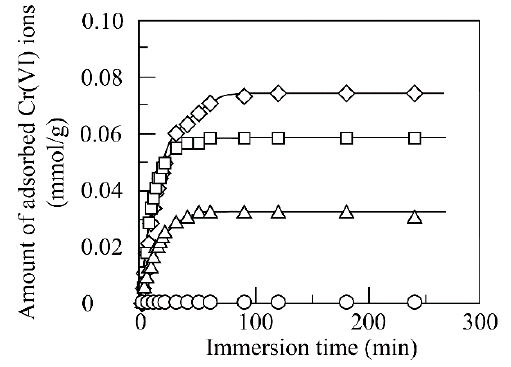
Figure 4. The time course of the Cr(VI) ion adsorption for untreated silica beads ( 〇 ) and AEAPTES silica beads with the amount of amino groups of 0.030 ( △ ), 0.080 ( □ ), and 0.220 ( ◇ ) mmol/g in a 0.20 mM K 2 Cr 2 O 7 solution at pH 3.0 and 30 °C .